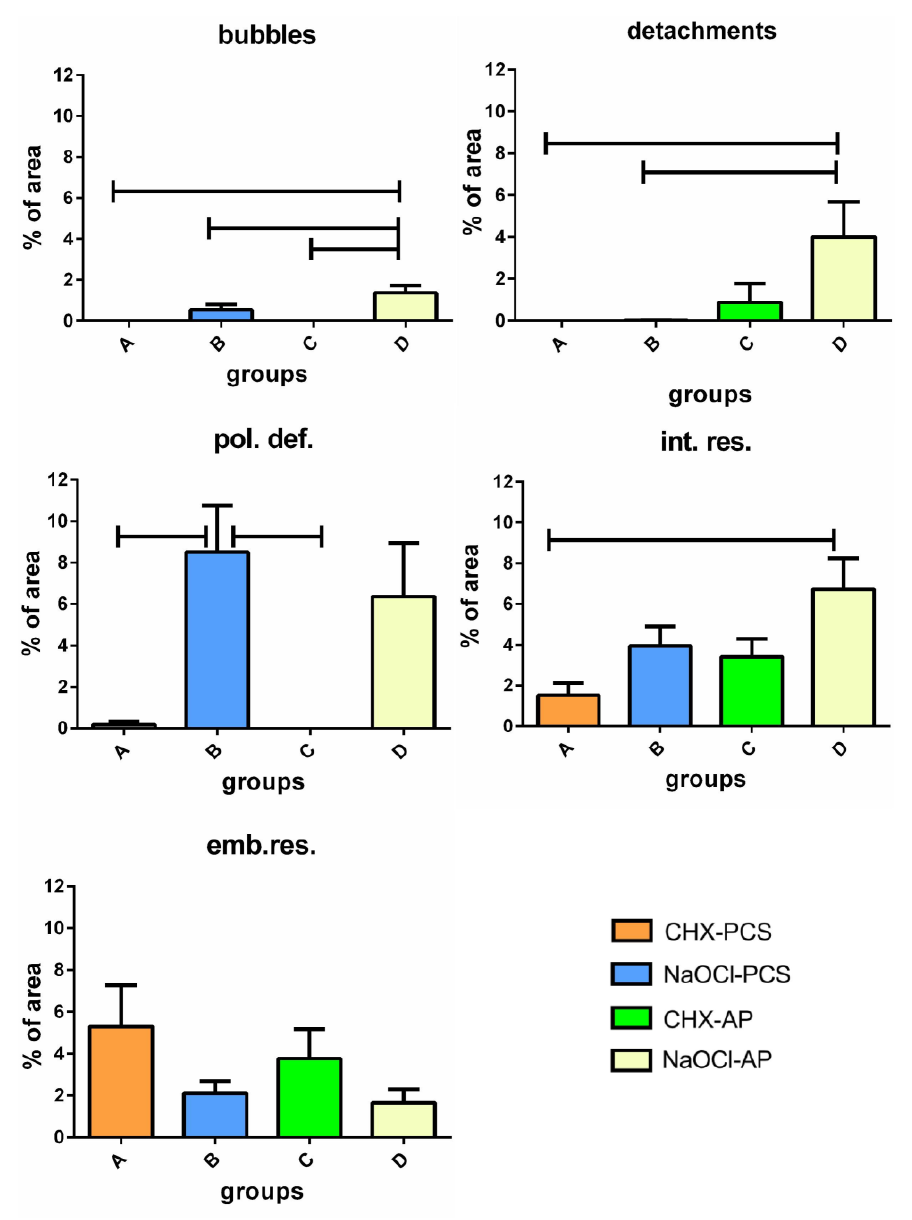
Figure 6. Mean (±Std. Err) percent area of each type of defect computed for the four groups. (pol.def = polymerization defects; int.res=endodontic cement residues at the dual cement-dentin interface; emb.res=embedded residues of endodontic cement into the dual cement